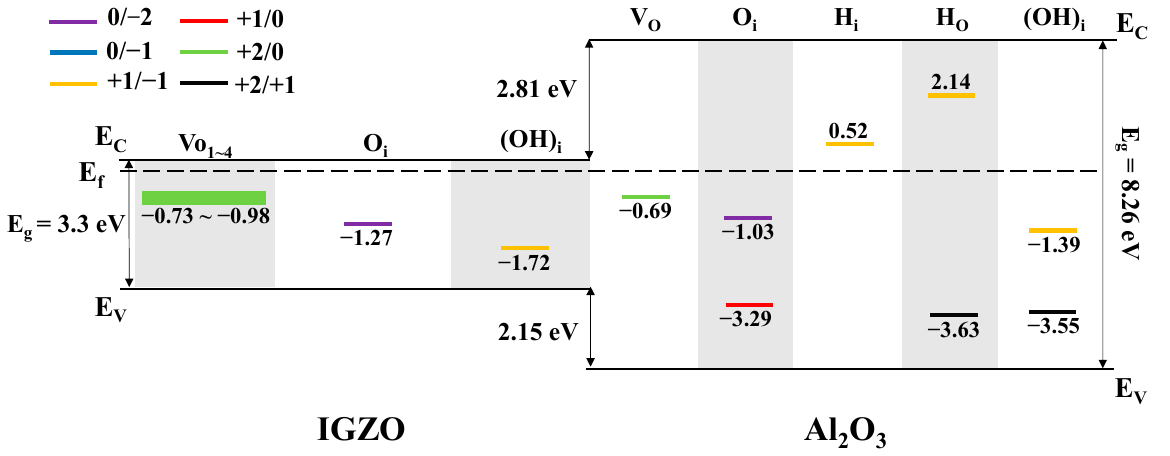
Figure 4. The band alignment and charged transition level of defects in Al 2 O 3 /IGZO. The numbers in the figure represent the energy from the transition level to the Fermi level of CAAC-IGZO.